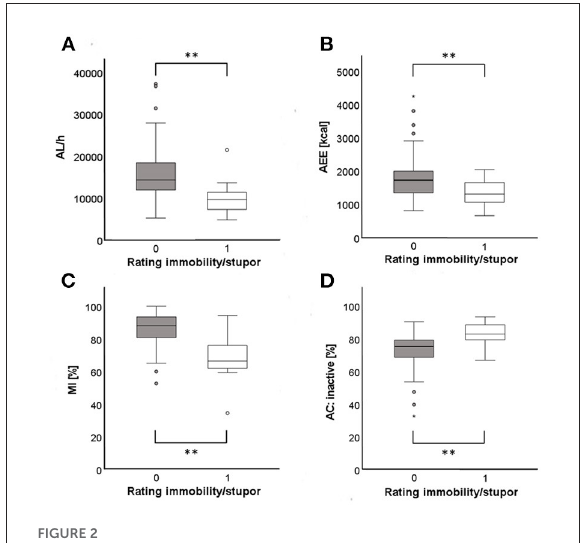
FIGURE2 Group differences in AL/h (A) , AEE (B) , MI (C) , and AC: inactive (D) between absence (rating 0) and occasional presence (rating 1) of the item immobility/stupor . **Denotes significant correlation p < 0.01. AL/h, activity level per hour; AEE, active energy expenditure; MI, motor index; AC, activity